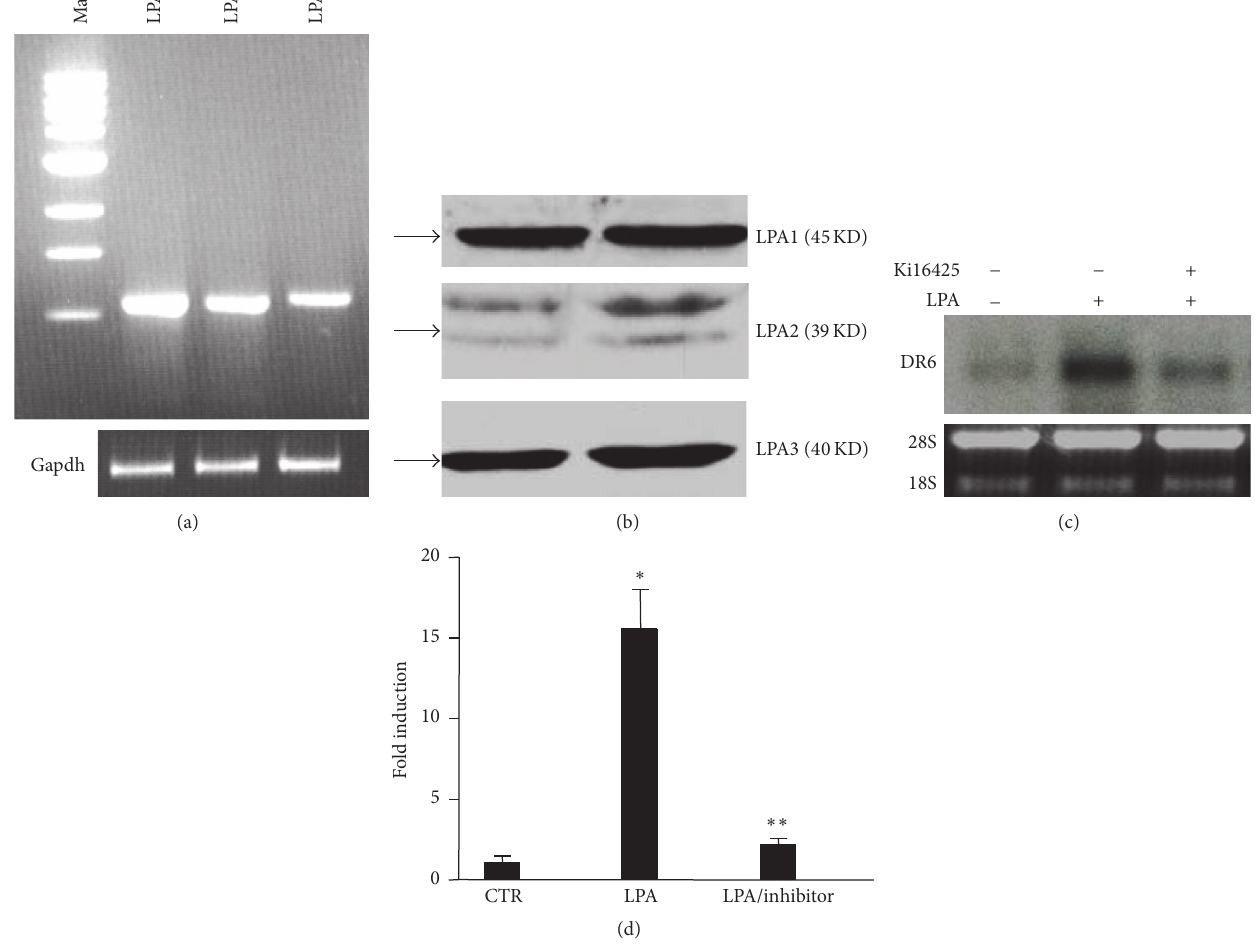
Figure 3: LPA-induced DR6 upregulation is mediated by LPA receptors 1/3 (LPAR1/3). (a and b), LPA1, LPA2, and LPA3 mRNA and protein are all expressed in HeLa cells, as indicated by PCR and Western blot, respectively. 𝑛 = 3 . (c) LPA1/3 antagonist Ki16425 (3 𝜇 M) attenuated the DR6 upregulation induced by LPA. 𝑛 = 4 . (d) The bar graphs are statistical analysis of DR6 expression. Data presented are mean ± SD from 4 independent experiments, with untreated controls set as 1. ∗ 𝑃 < 0.001 versus control; ** 𝑃 < 0.001 versus